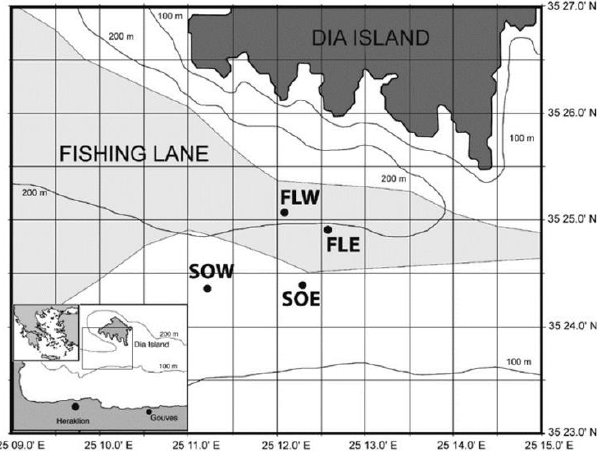
Figure 1. Study area showing trawling lane and control sites in Heraklion Bay, Crete (FLE, fishing lane east; FLW, fishing lane west, SOE, control area east; SOW, control area west).